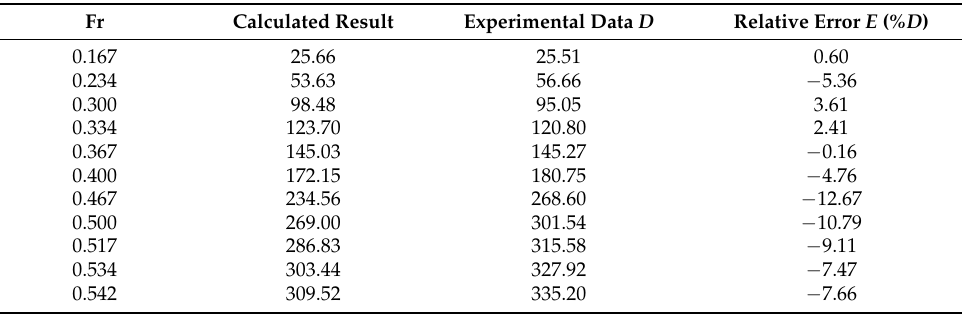
Figure 8. Numerical results (CFD) and experimental data (EFD) of bare hull resistance. Table 3. Bare hull resistance R m (N).